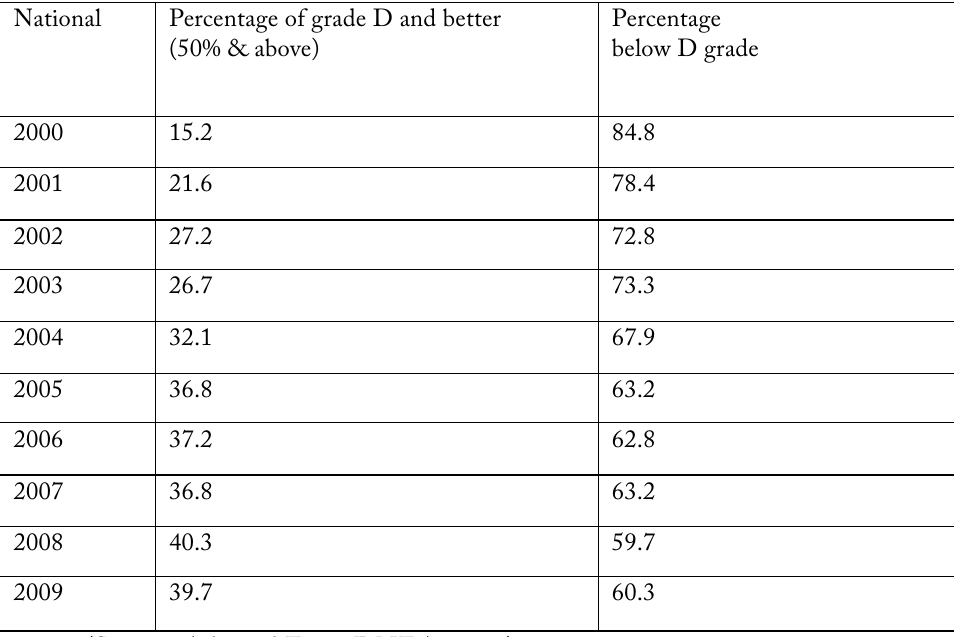
Table 1: National Performance in JSC Results: 2000-2009 National Percentage of grade D and better Percentage (50% & above) below D grade 2000 15.2 84.8 2001 21.6 78.4 2002 27.2 72.8 2003 26.7 73.3 2004 32.1 67.9 2005 36.8 63.2 2006 37.2 62.8 2007 36.8 63.2 2008 40.3 59.7 2009 39.7